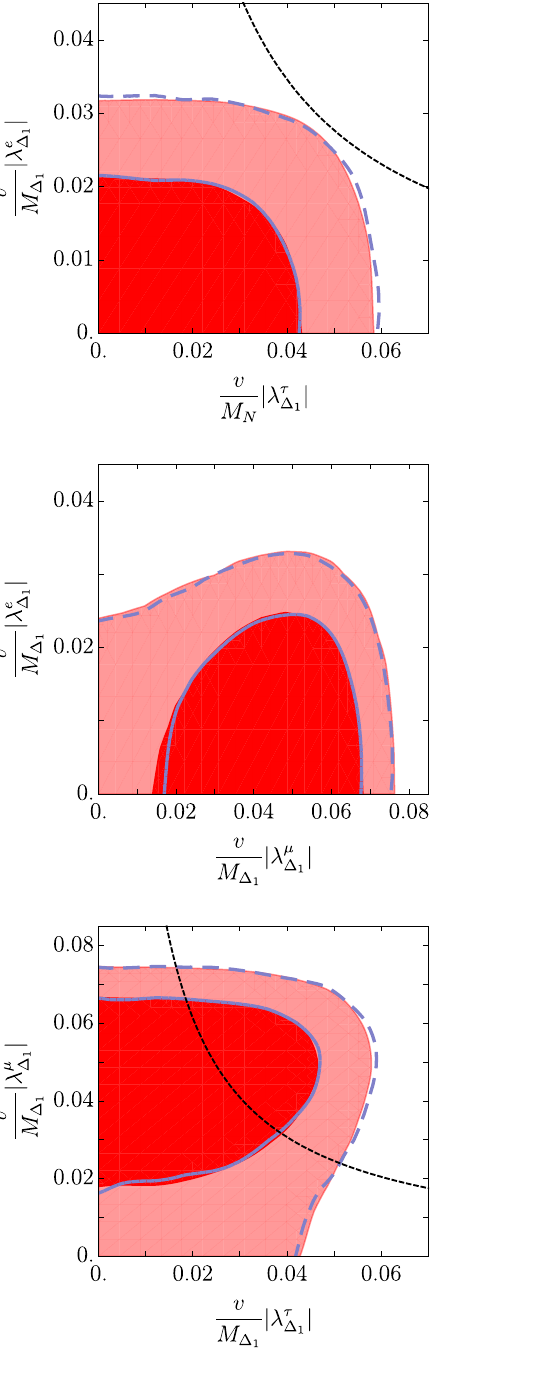
Figure 6 . Preferred regions for ∆ 3 . The color coding is the same as in figure 3 and the black line indicates the exclusion by τ → 3 µ or τ → 3 µ in case of one generation of VLLs. The exclusions from µ → e processes are very stringent and for better visibility shown in figure